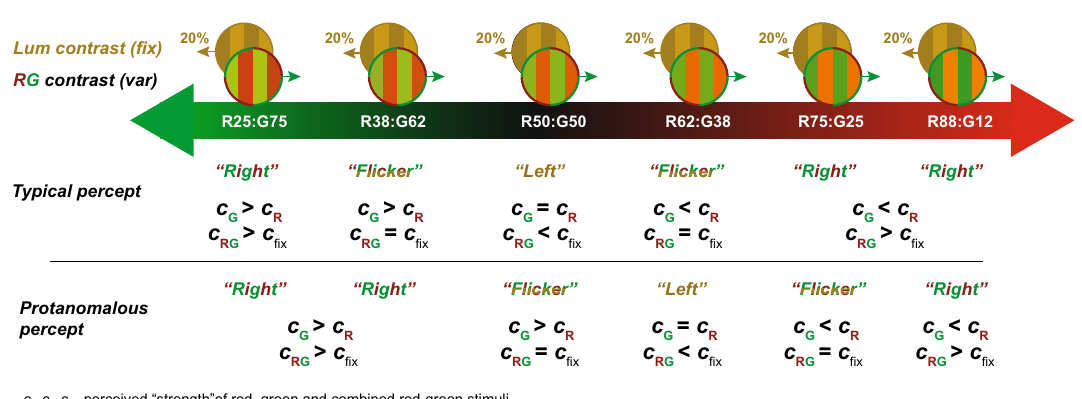
Figure 3. Perception of direction in the eye-tracking test. (Top row) Stimuli are comprised of a fixed-contrast (20%) yellow luminance grating added to a R-G coloured grating. (Middle row) When a yellow grating is superimposed on an equiluminant RG grating (R50:G50), a CVn observer will report the direction of the yellow component, because its contrast exceeds C Eq. Increasing the luminance of either the red or green component first nulls the fixed-contrast component (leading to flicker) and then exceeds it (at which point observers report direction of the R-G grating). (Bottom row) By comparison, an observer with protanomalous colour vision who perceives red as weaker than green—produces responses shifted right along the stimulus axis. Note how the observers require more red (here R62:G38) to achieve